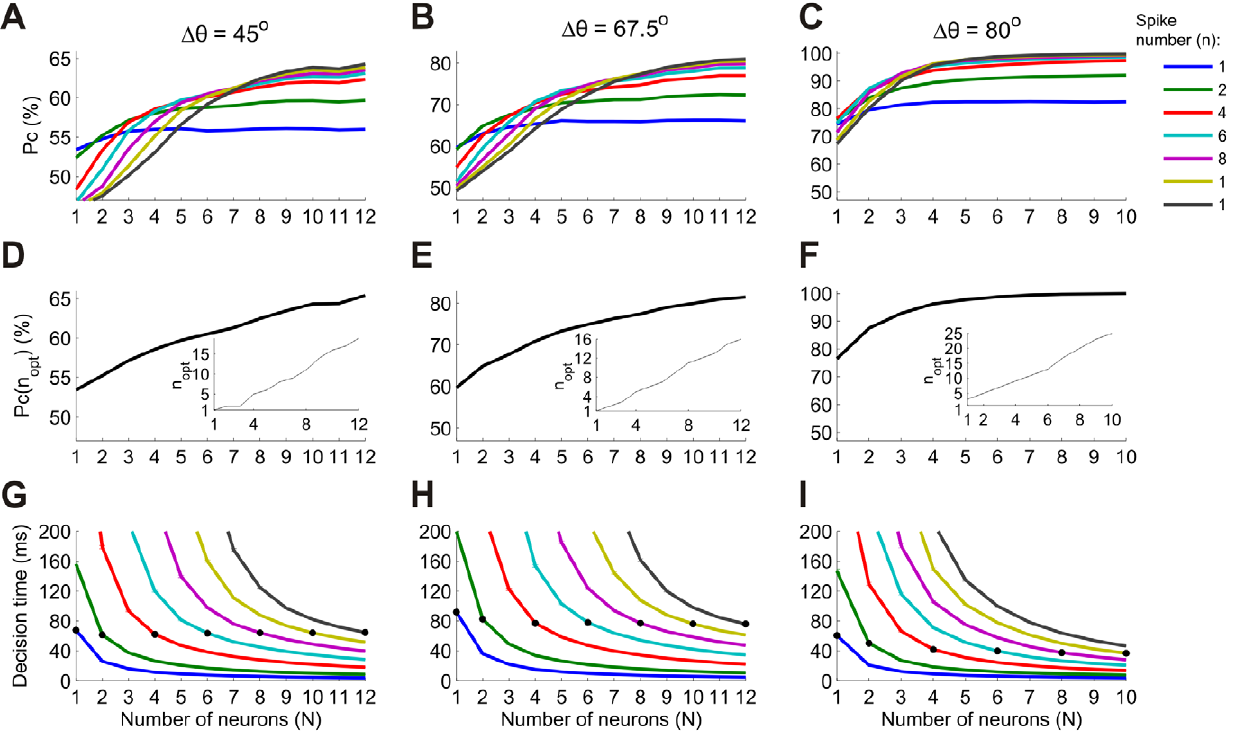
Figure 7. Orientation discrimination using the n -tWTA readout in populations of neurons. (A–C) Probability of correct discrimination (Pc) as a function of population size ( N ) for two populations that differ in preferred orientation by 45 u (A), 67.5 u (B) and 80 u (C). Different curves correspond to different values of n (see legend). (D–F) Probability of correct discrimination using the optimal value of n for each N (for the above pairs of populations). The inset shows the optimal n for each N . (G–I) Mean decision times relative to the onset signal for the neurometric curves in the top panels. (Decision times larger than 200 ms are not shown. Error bars represent 6 standard error of the mean). The black circles mark the decision times when n = N ; i.e., when the number of spikes used for the decision is equal to the group size. Note that the data for the left two columns are from dataset 5 in Table 1 whereas the data for the right column are from dataset 3. These datasets had different levels of spontaneous and evoked firing, which are responsible for the differences in the optimal n and in the decision